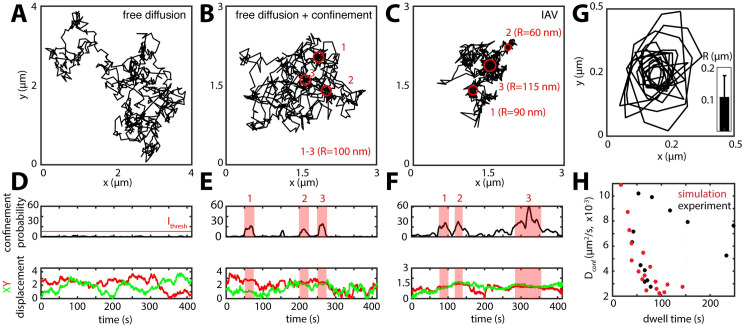
IAV performs a receptor concentration-driven random walk on the plasma membrane.Based on our quantitative analysis of the AF distribution on A549 cells, we hypothesize a motion behavior that is driven by the local AF concentration. We simulate this behavior initially as a 2D random walk with free diffusion coefficient Dfree (A). (B) Next, we simulate AF clusters (red circles, r = 100 nm), which would, due to the increased SA concentration, lead to a temporal confinement (Dconf < Dfree). To identify confined regions within the simulated virus trajectories, we establish a confinement probability Iconf. Accordingly, a free diffusing particle shows only fluctuation in of Iconf (D), while the addition of temporal confinement leads to a clear increase that overlaps with stationary phases of the particle as visible in the XY displacement plot (E). We used the confinement probability to analyze experimental virus trajectories in particular the mixed type of trajectories (C) (see also S8 Fig) (C). Iconf shows a clear signature of temporal confinement (F) similar to the model prediction (E). As a further challenge for our model, we performed a subtrajectory analysis, thereby extracting the dwell time, Dconf as well as the area of the respective temporal confinement in our virus trajectories. (G) shows an overlay of the perimeters of the extracted confined regions as well as the average radius (R). From our simulated data, correlation of Dconf with the dwell time shows that a local increase in AF concentration (i.e. decreased diffusion) due to the encounter of an SA nanodomain leads to an increased local dwell time (H, red markers). We observed a similar behavior, when we tested the confinement dwell time in experimental virus trajectories (H, black markers).